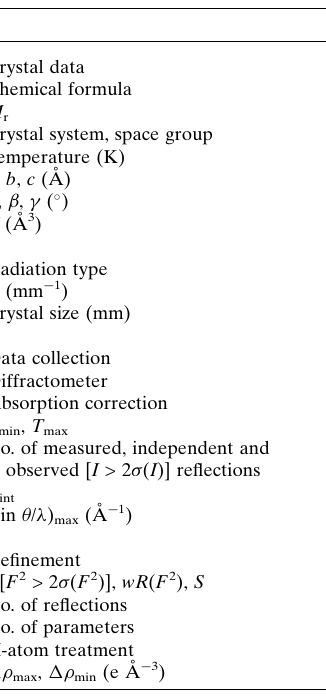
Table 4 Experimental